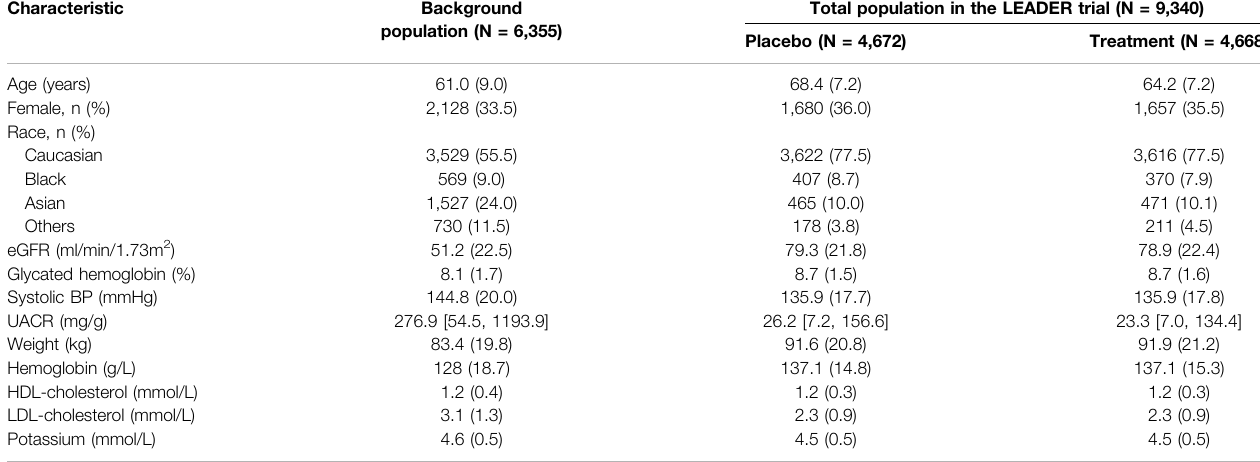
TABLE 1 | Baseline characteristics of patients included in the background dataset and in the LEADER trial. Characteristic Background Total population in the LEADER trial (N = 9,340) population (N = 6,355)